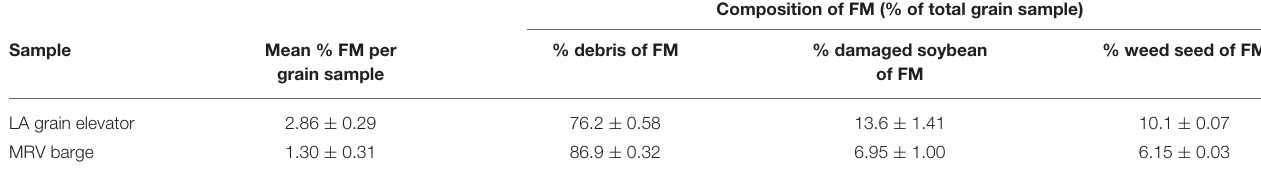
TABLE 1 | Percentage ( ± SE) of the foreign material samples components for the Louisiana (LA) grain elevators (2018 and 2019 data pooled) and Mississippi River Valley (MRV) barge samples.